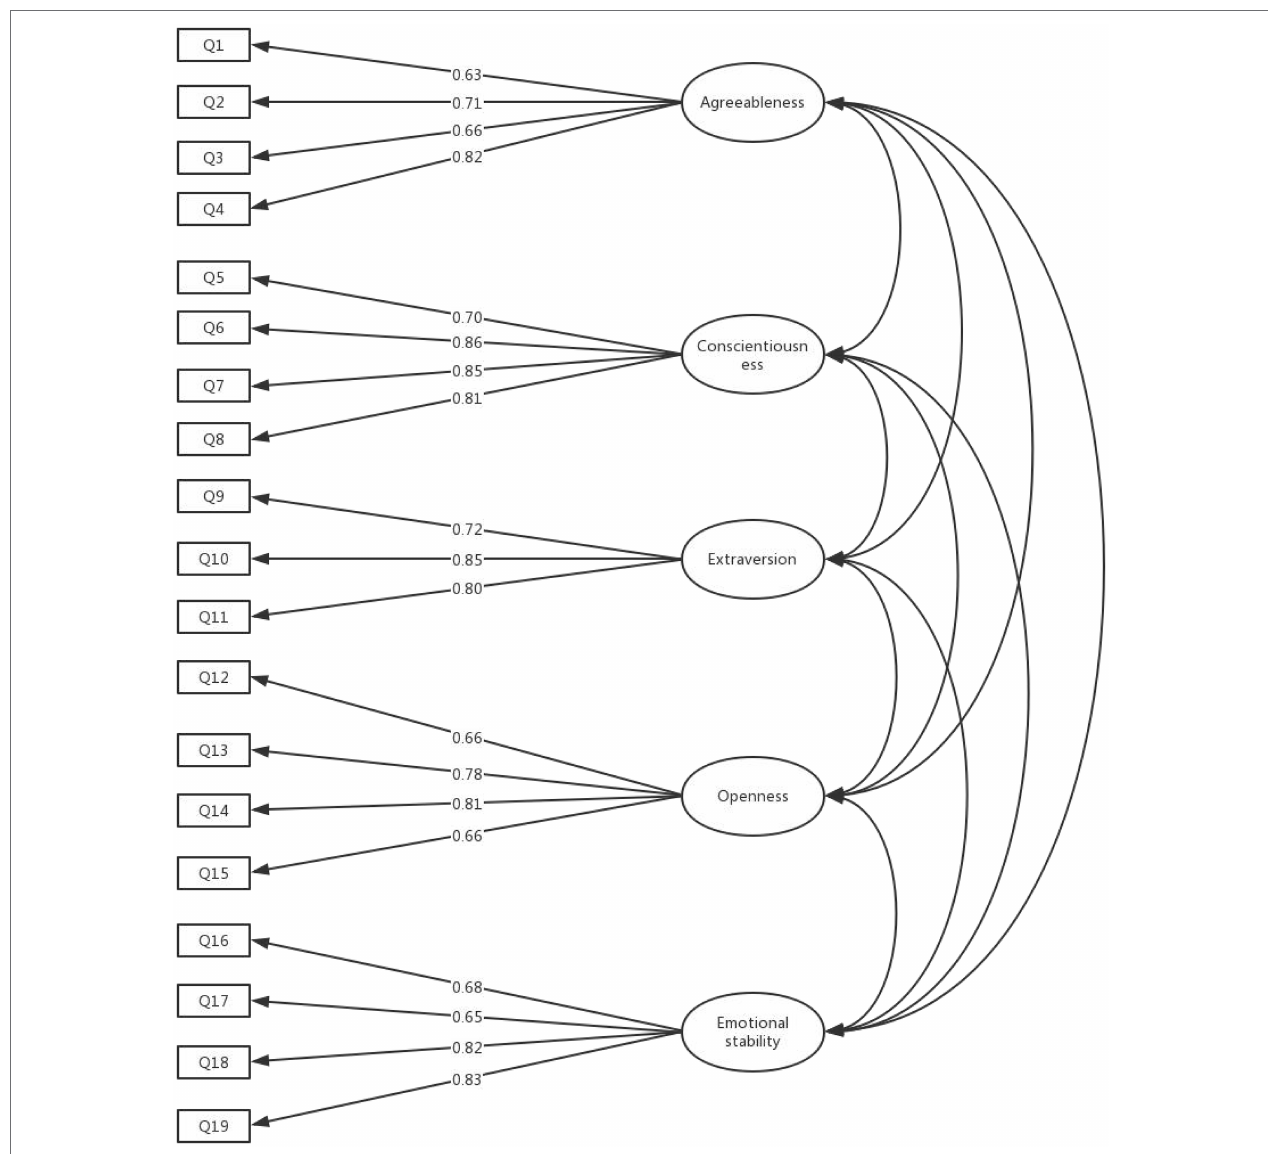
FIGURE 1 | Confirmatory factor analysis result of the five-factor correlational model in Study